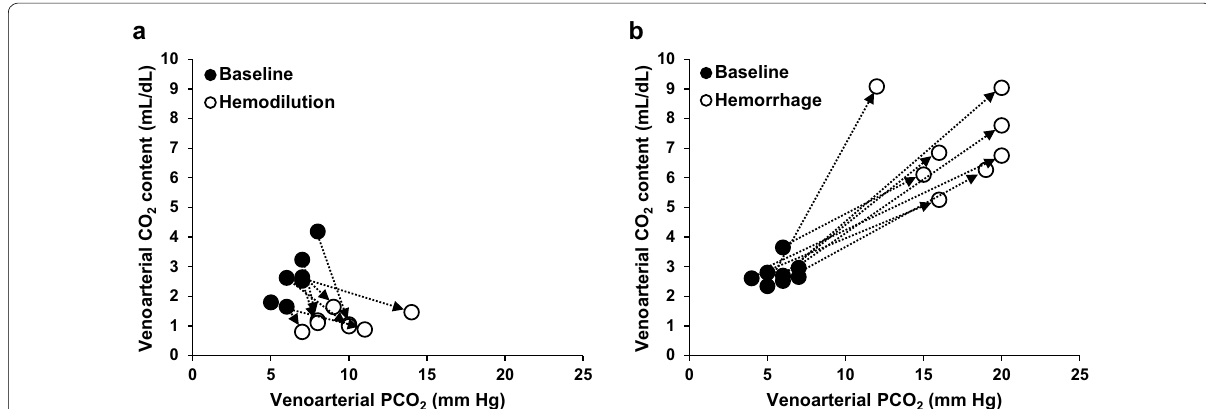
Fig. 4 Changes in the relationship between venoarterial CO 2 pressure and content differences in hemodilution ( a ) and hemorrhage ( b ). Hemodilu- tion shifted CO 2 Hb dissociation curve to the